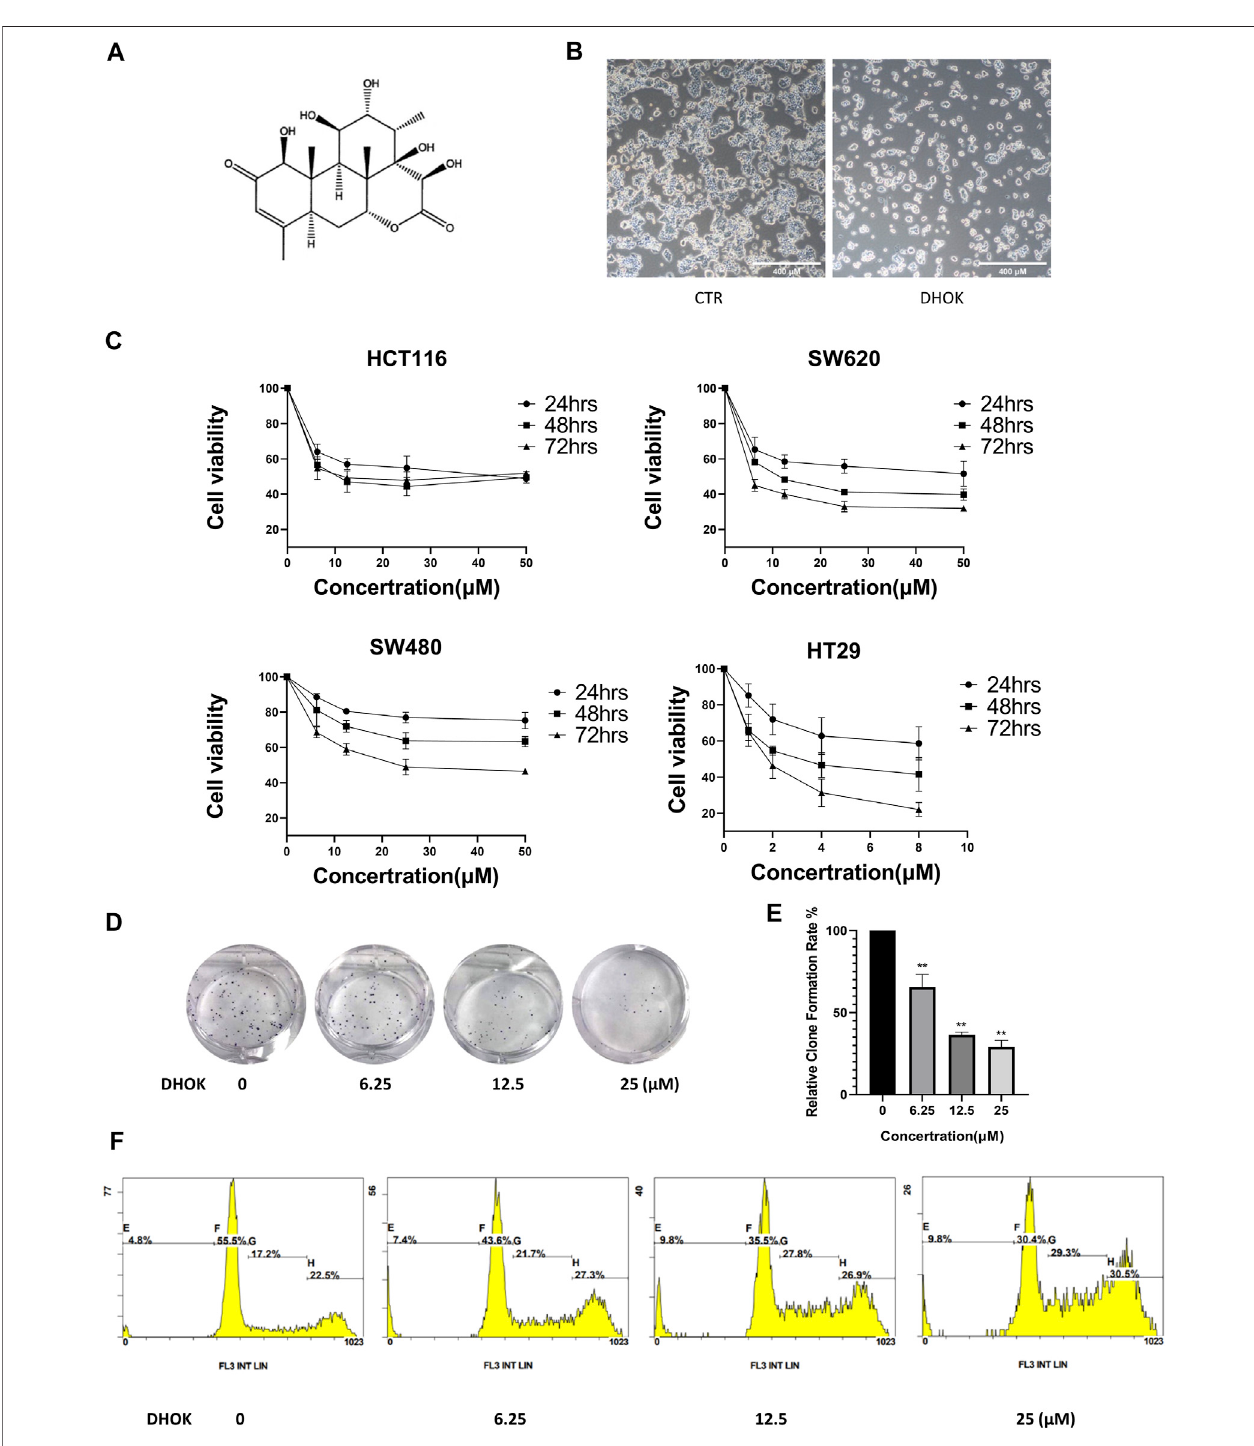
FIGURE1| DHOKinhibitshumanCRCcellproliferation. (A) ThestructureofDHOK. (B) CellmorphologyofSW620cellswithorwithoutDHOKtreatment(12.5 μ M, 24 h).Scalebar400 μ m. (C) CellviabilityofSW620,SW480,HCT116,andHT29cellsunderdifferentdosageofDHOKtreatment(6.25,12.5,25 μ M;or1,2,4,8 μ M)for 24,48,or72 h (D,E) ColonyformationassayofSW620cellsafterdifferentdosageofDHOKtreatment(6.25,12.5,25 μ M).Thenumberofformedcolonieswascounted and statistically analyzed ** p < 0.01. (F) The cell cycle of SW620 cells was analysed under DHOK treatment.